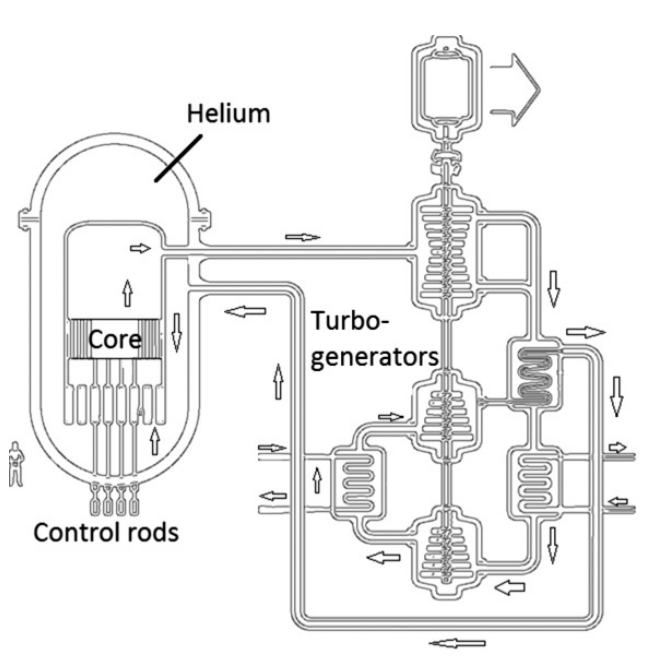
Fig. 5. – Schematic representation of a gas-cooled fast reactor with indirect cycle loops consisting of an heat exchanger and an integrated high-speed